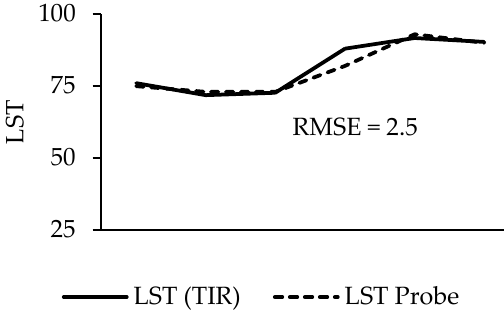
Figure 11. LST validation.